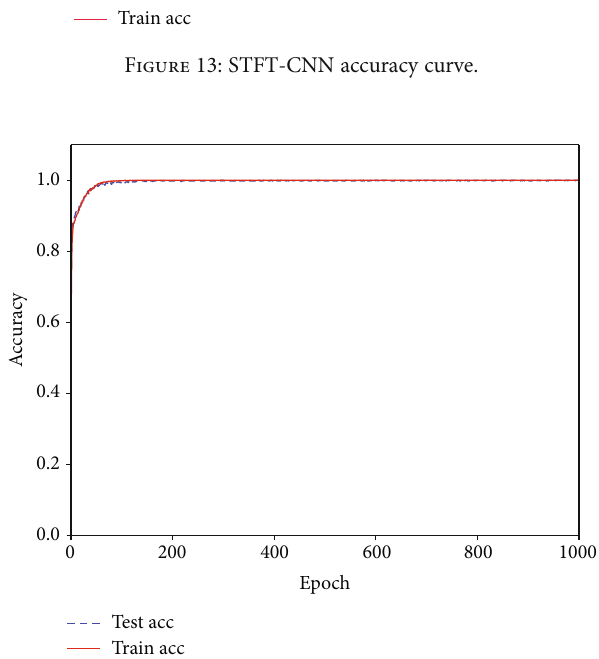
Figure 14: EMD-CNN accuracy curve. Table 1 lists the calculation results for the 1000th itera- tion. The reliability and e ff ectiveness of the proposed model were con fi rmed by the deep learning training dataset and test dataset.